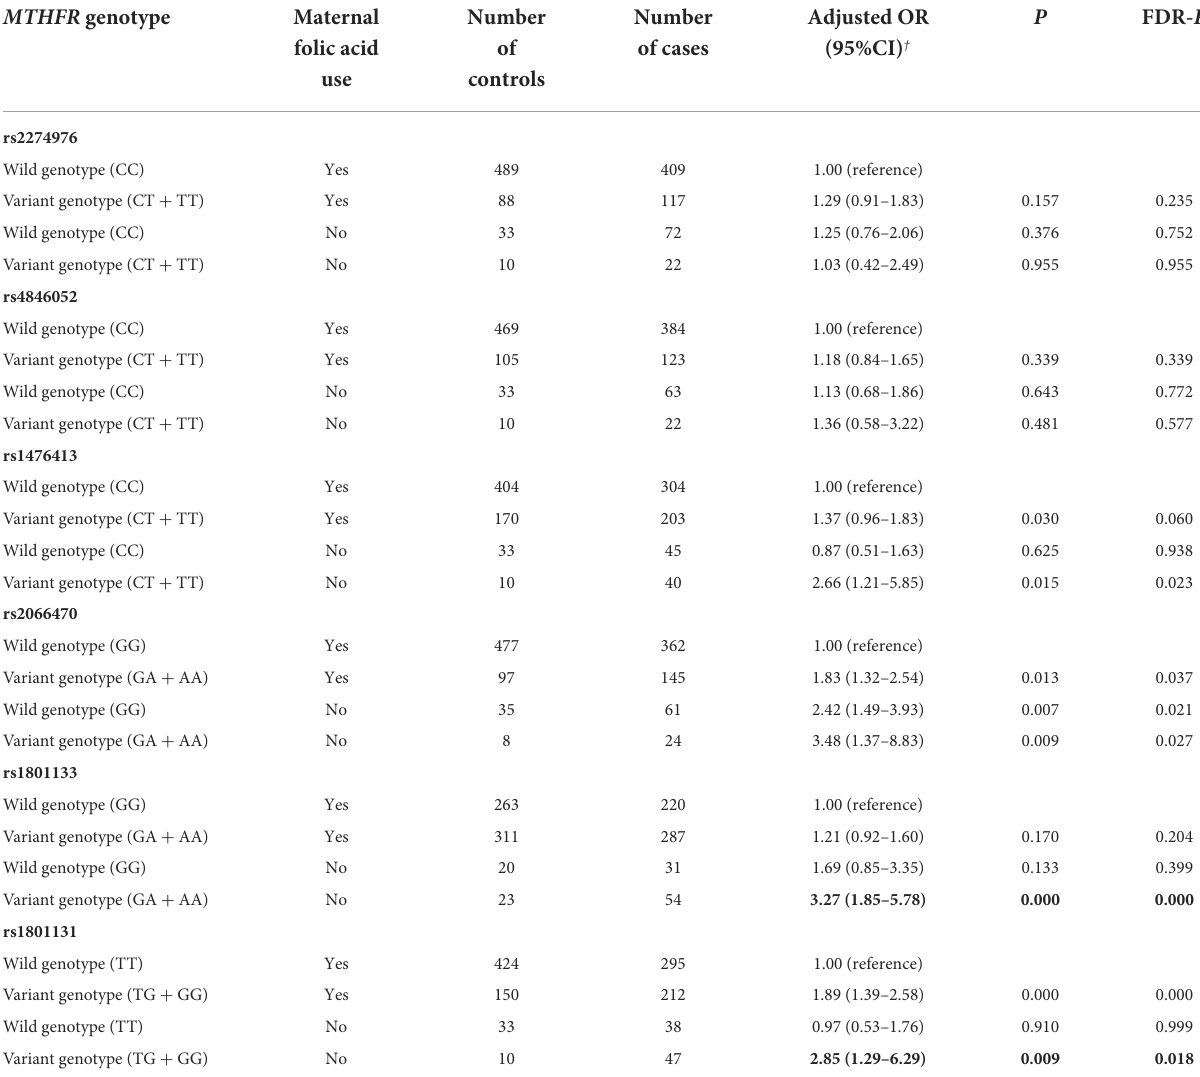
TABLE 4 Crossover analysis in assessing the gene-environmental interaction between the MTHFR gene and maternal folic acid supplementation for risk of CHD. MTHFR